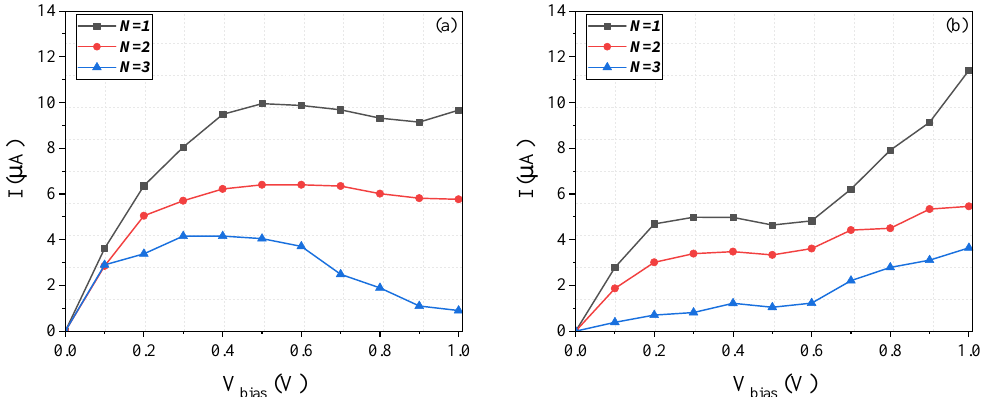
Figure 11. The current–voltage ( I − V ) characteristics for ( a ) graphene-based and ( b ) silicene- based